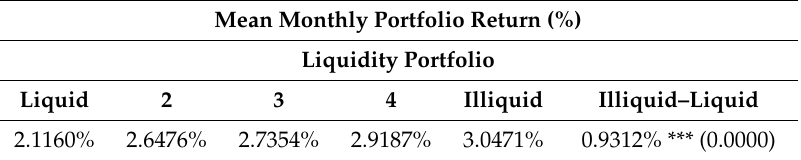
Table 4. Average monthly returns for quintile portfolios (post financial